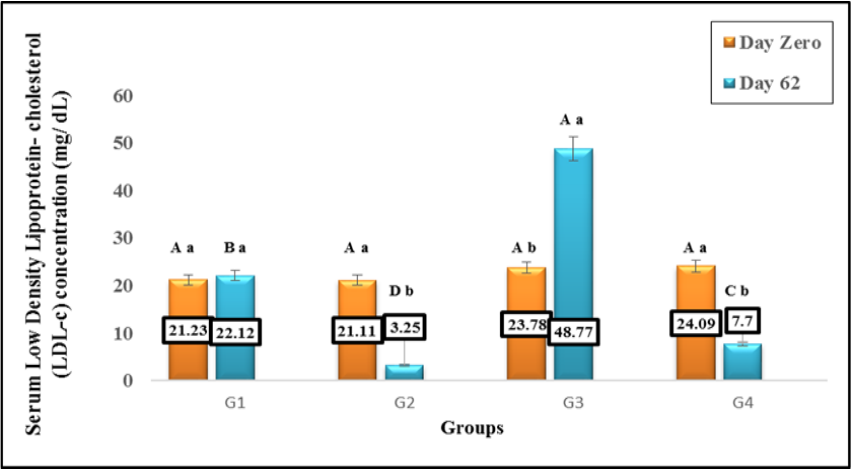
Figure 4. Effect of phosphatidylcholine, fructose and/or combination on serum low density lipoprotein-cholesterol (LDL-c) concentration (mg/dL). Mean ± SE, n = 9 in a group. G1 control groups (C), G2: (Pc), G3: (Fr), G4: (Fr + Pc). A-C Significant variations P ≤0.05 between peroids